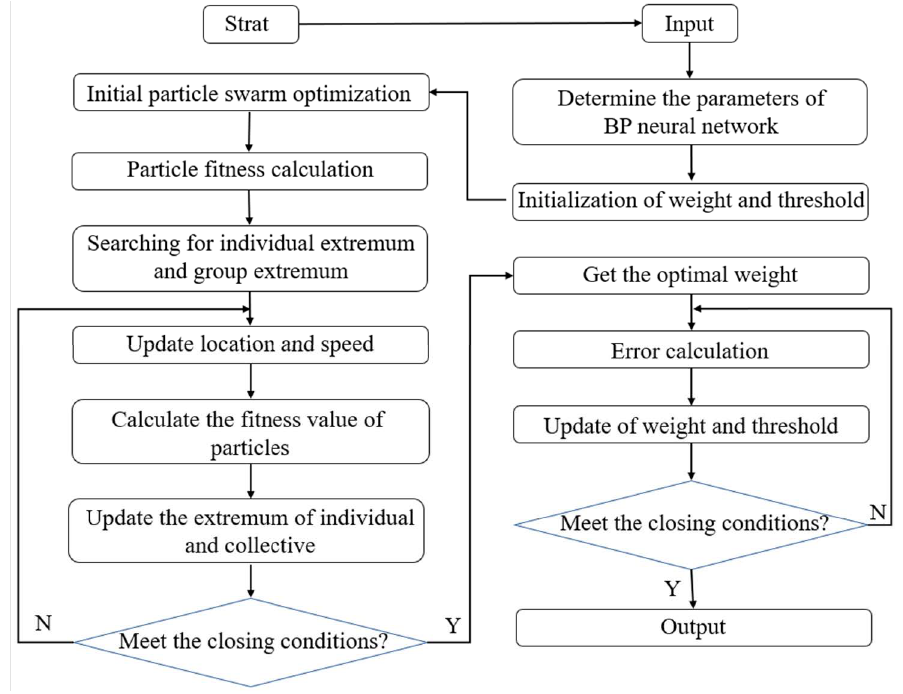
Figure 9. Flow of the PSO-BP integrated model algorithm.